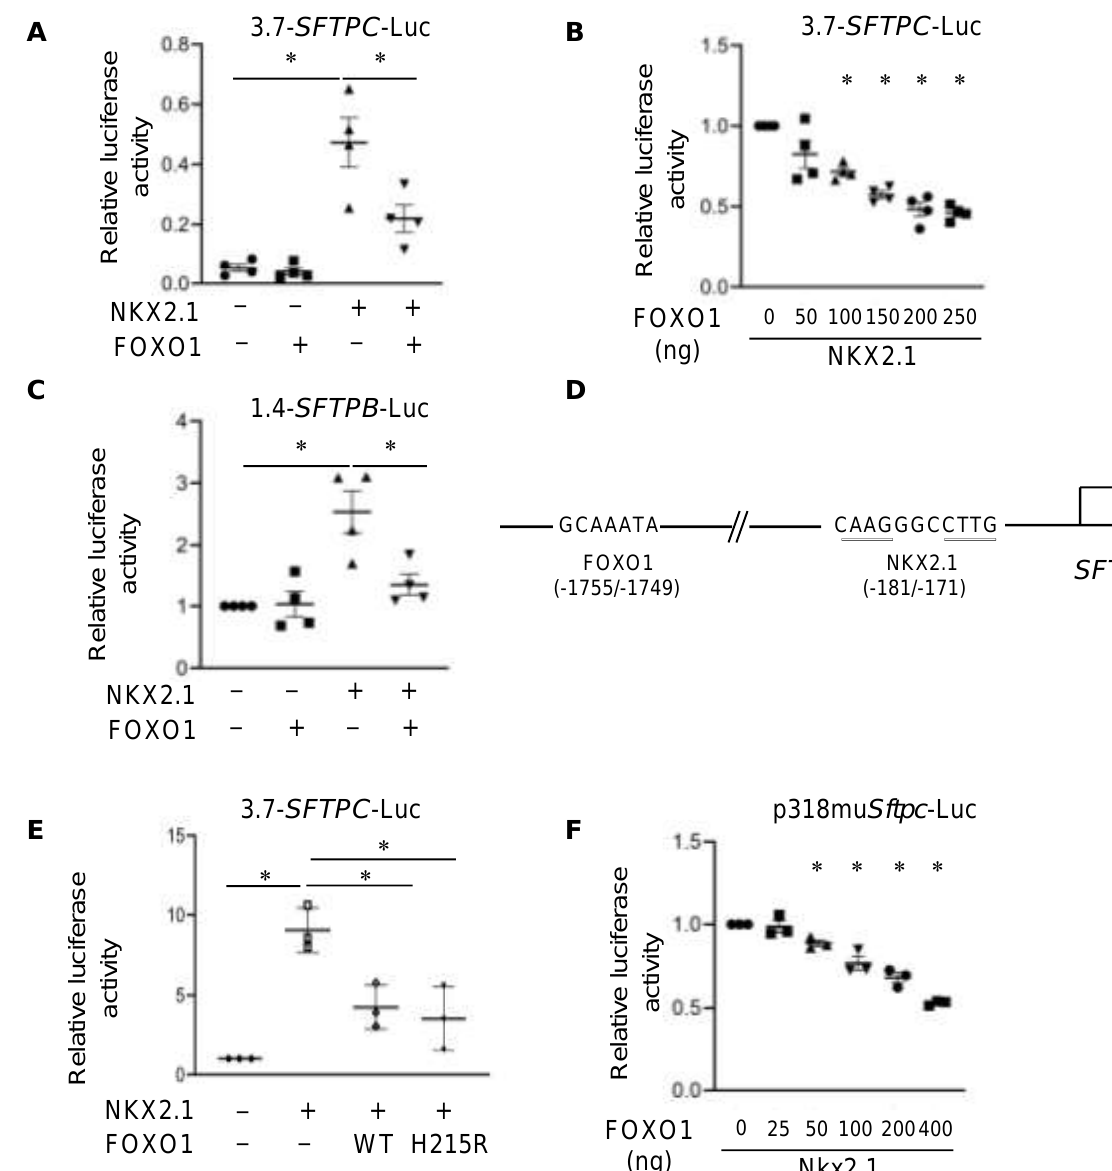
Figure 2. FOXO1 attenuates NKX2.1 activation of SFTPC and SFTPB . ( A ) MLE-15 cells were co- transfected with a 3.7 kb SFTPC reporter construct (3.7- SFTPC -Luc) and NKX2.1 or FOXO1 expression constructs alone or in combination. Dual luciferase assays 48 h following transduction showed that FOXO1 inhibited NKX2.1 activation of the SFTPC reporter. Firefly luciferase activity was normalized to Renilla luciferase. n = 4 for each group. One-way ANOVA, asterisk indicates p < 0.05. ( B ) MLE-15 cells were co-transfected with 3.7- SFTPC -Luc, pRC/CMV/ NKX2.1 and increasing concentrations of FOXO1 expression construct. Dual luciferase assays 48 h post-transduction showed that FOXO1 inhibited NKX2.1-mediated induction of the SFTPC reporter in a dose-dependent manner. The data are shown as normalized to the absence of FOXO1. n = 4 for each group. One-way ANOVA, asterisk indicates p <0.05 compared to absence of FOXO1 (empty vector). ( C ) MLE-15 cells were co- transfected with a 1.4 kb SFTPB reporter construct (1.4- SFTPB -Luc), NKX2.1 and FOXO1 expression constructs alone, or in combination. Dual luciferase assays 48 h post-transduction showed that FOXO1 inhibited NKX2.1 activation of the SFTPB reporter. Firefly luciferase activity was normalized to Renilla luciferase. The data are shown as normalized to the absence of FOXO1 and NKX2.1. n = 3 for each group. One-way ANOVA, asterisk indicates p <0.05. ( D ) Schematic showing the puta- tive FOXO1 and NKX2.1 binding sites on human SFTPC promoter. ( E ) MLE-15 cells were co-trans- fected with a 3.7 kb SFTPC reporter construct (3.7- SFTPC C-Luc), NKX2.1 and FOXO1 wild-type (WT), or FOXO1H215R (DNA binding mutant) expression constructs alone or in combination. Dual luciferase assays 48 h post-transduction showed that FOXO1-H215R maintained the ability to re- press NKX2.1 activation of the SFTPC reporter. Firefly luciferase activity was normalized to Renilla